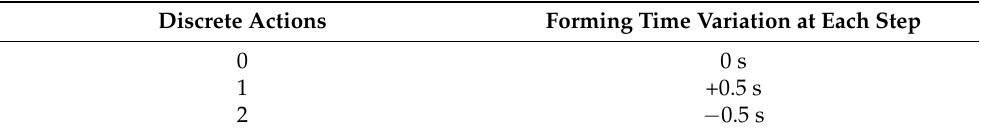
Table 3. Description of the MDP action